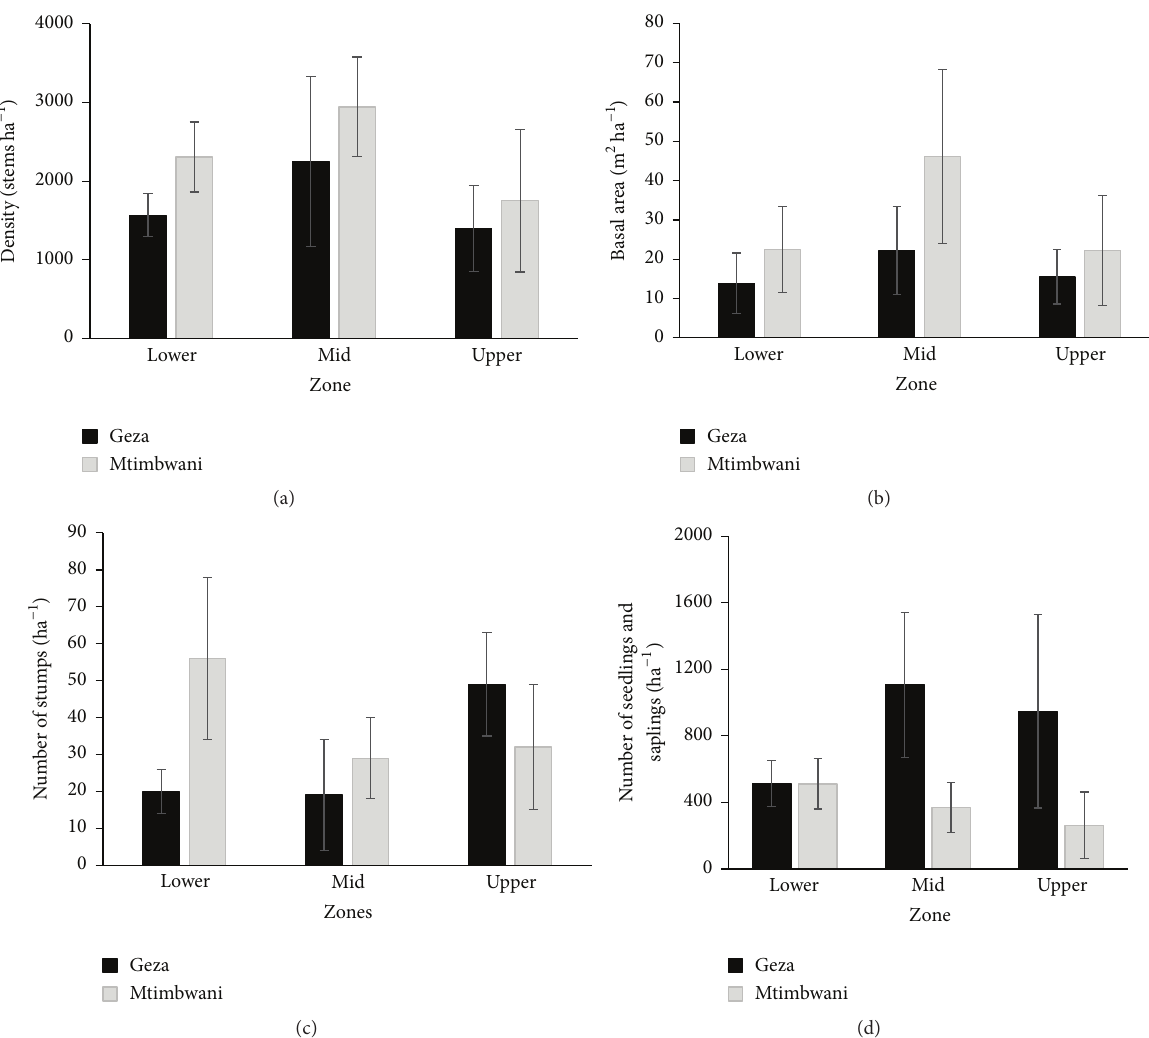
Figure 2: Forest structure indicating (a) stems density (b), basal area, (c) number of stumps, and (d) potential regeneration in different zones (mean ± SD).